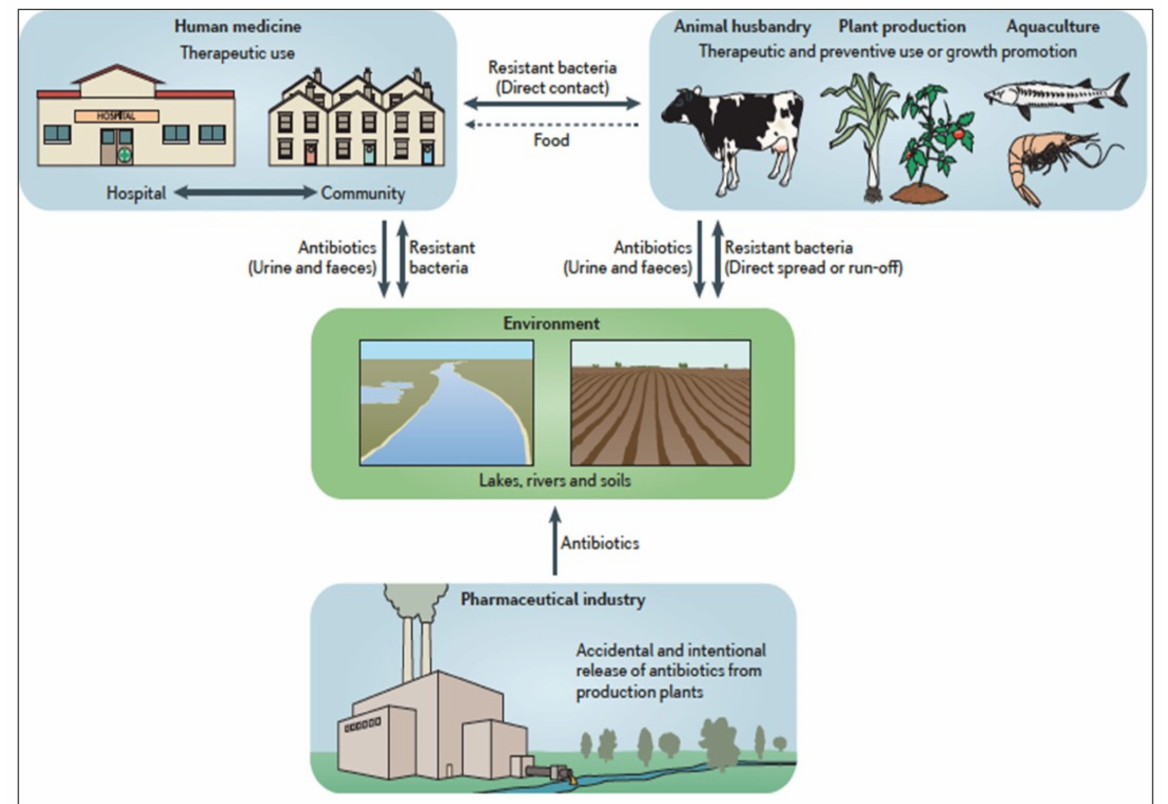
Figure 1. Ecology of antibiotic resistance. Reproduced with permission from Andersson et al., 2014 [1]. An overview of the ecological impact of antibiotics, sowing how these drugs are cycled between different environments, such as the medical environment, agricultural settings, the aquacultural environment, the pharmaceutical industry, and the wider environment. A large percentage of the antibiotics that are used globally (20–80% depending on the antibiotic class) are released in the environment in an active form, via the excretion of drugs in urine and faeces and the intentional or accidental release of drugs. Thus, antibiotics will exert selective pressure on bacteria in humans, animals and plants, owing to international use, and in the wider environment, owing to unintentional spill-over. This imposes a widespread selective pressure on bacteria, leading to the selection of resistant strains, which are also capable of transmitting between different environments, thereby creating the potential for the global movement of antibiotic-resistant genes and determinants